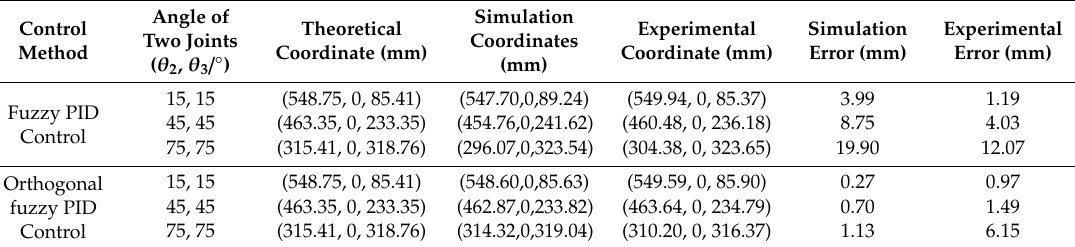
Table 11. Comparison of simulation and experimental